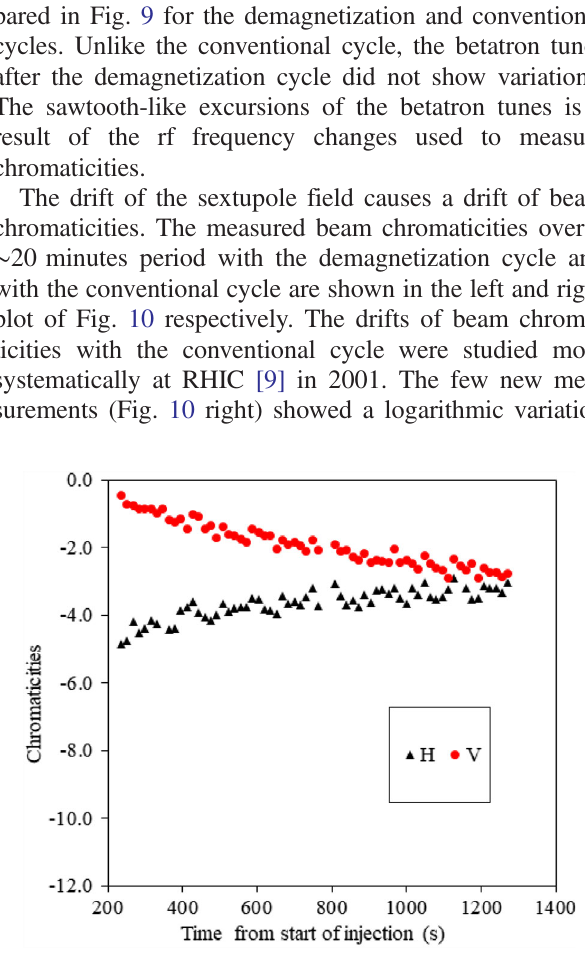
FIG. 11. Drift of the measured beam chromaticities, reproduced from Fig. 3 in Ref. [9], after a conventional